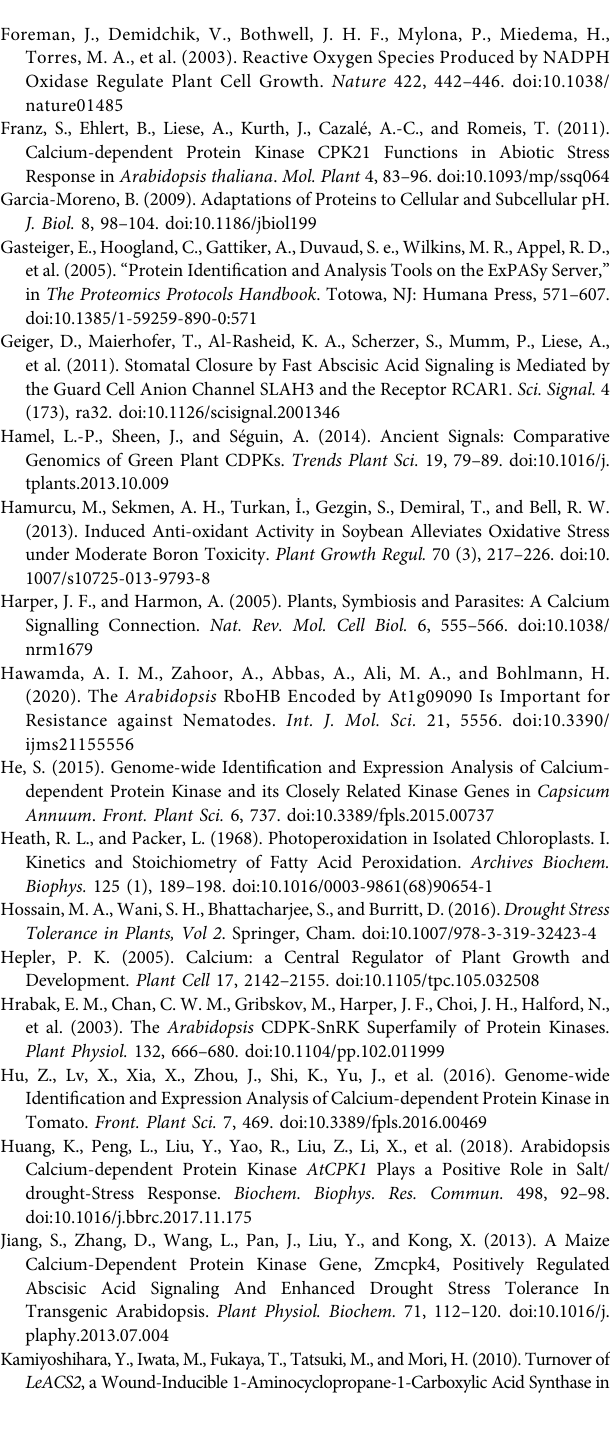
Supplementary Figure S1 | Synteny analysis of CDPK genes among S. tuberosum genome and A. thaliana, O. sativa , and S. lycopersicum .